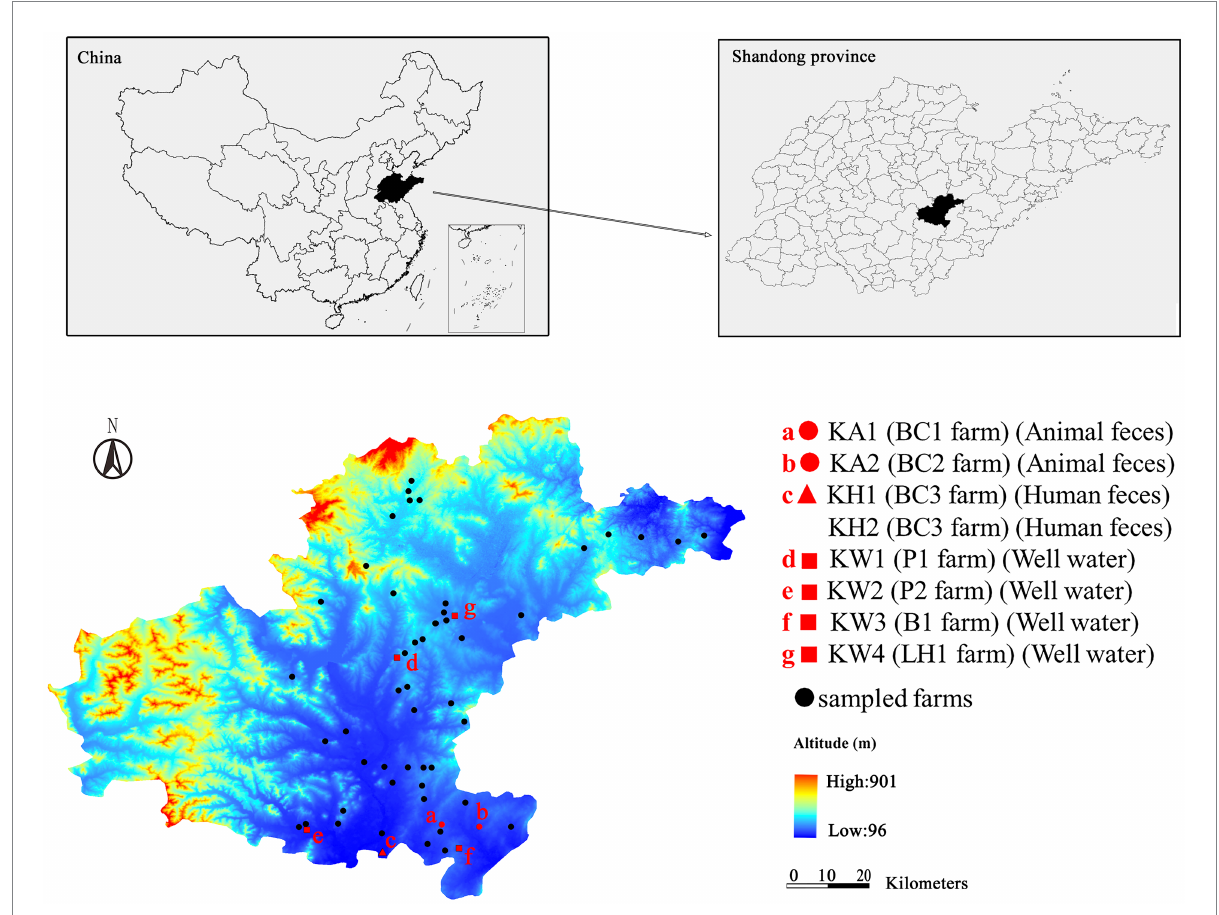
FIGURE 1 Map showing the location of the CRK-negative farms (denoted by black dots) and CRK-positive farms (denoted by red dots). The farms denoted “a” and “b” represent the farms in which CRK was isolated from animal feces. The red triangles (c) represent the farm in which CRK was isolated from human feces. Red squares (d, e, f, and g) represent the farms in which CRK was isolated from well water. BC1, BC2 and BC3 are broiler chicken farms; P1 and P2 are pig farms; B1 is a beef farm; LH1 is a laying hen